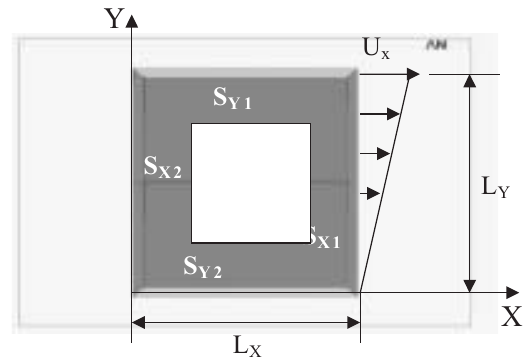
Figure 3 Loading and boundary condition in determining G XY